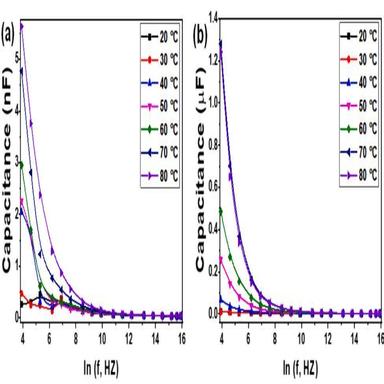
C-f curves for (a) pure PVA and (b) PVA/Gr-7 wt% NQNs at various temperatures ranging from 20 ◦C to 80 ◦C, at an applied voltage of 1 V across a frequency range from 50 Hz to 8 MHz.